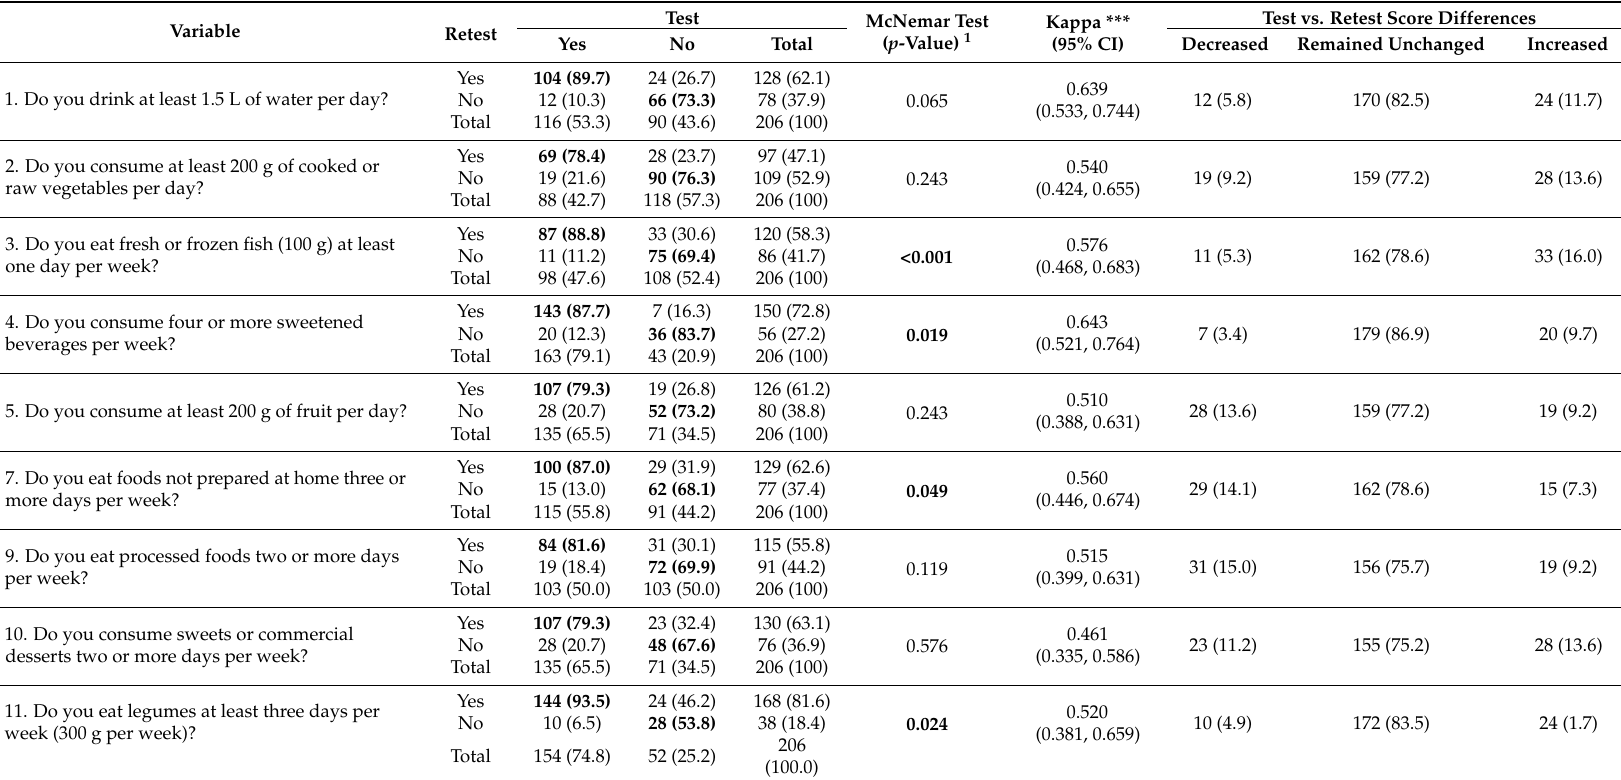
Table 5. Agreement between Mini-ECCA questions with dichotomous responses ( n =